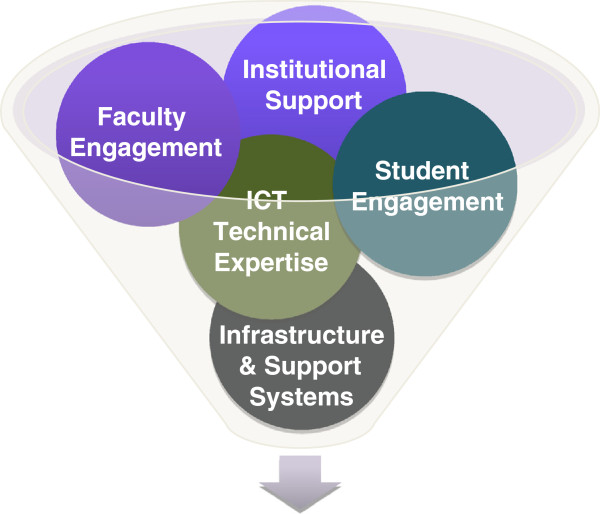
E-learning strategy.